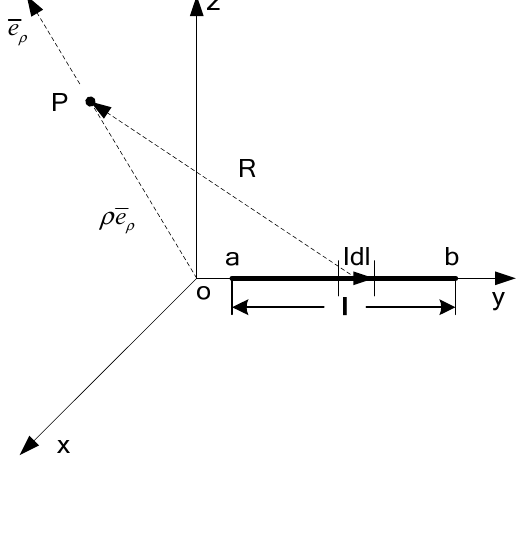
Figure 10. The magnetic flux density of finite current-carrying